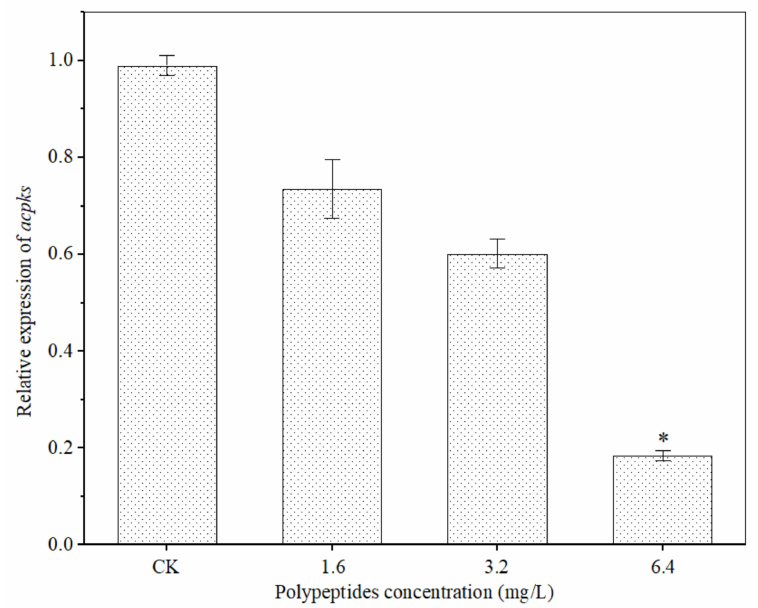
Figure 10. Effects of polypeptides on expression of the OTA polyketide synthase gene acpks in A. carbonarius . *, significant difference ( p <